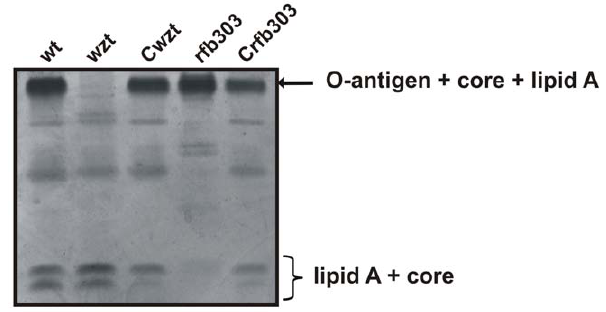
Figure 1. Analysis of Xac LPSs by SDS-PAGE. LPSs were isolated from Xac wild-type (lane 1), Xac wzt (lane 2), Xac Cwzt (lane 3), Xac rfb303 (lane 4) and Xac Crfb303 (lane 5) strains by the hot phenol method. The polyacrylamide gel was run with a tricine buffer system and subsequently silver-stained.